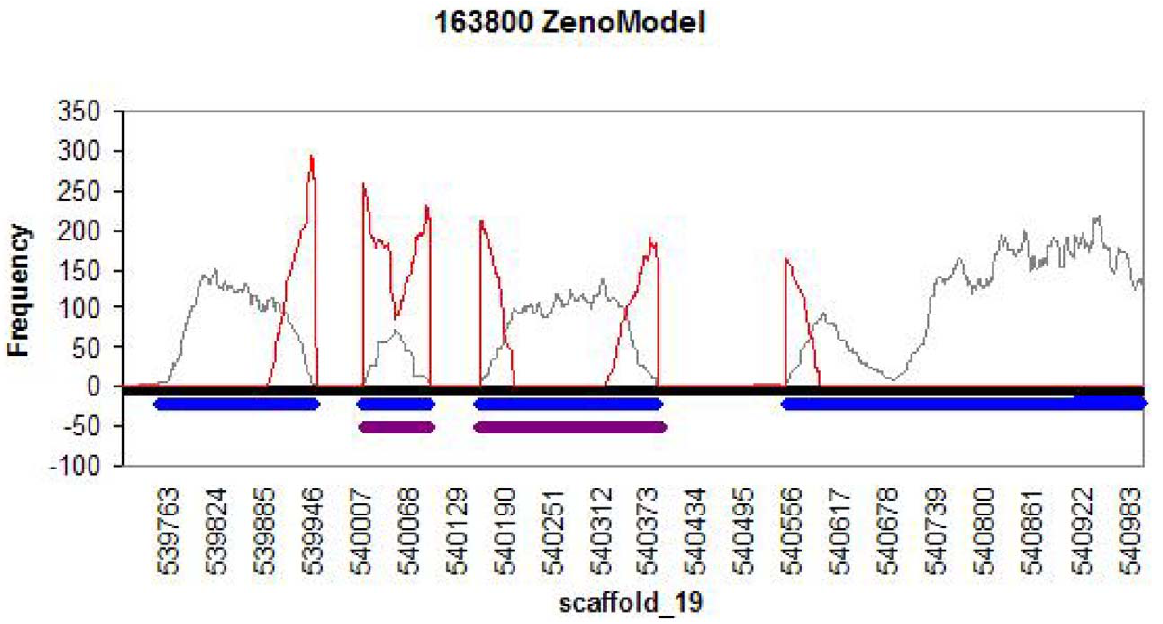
Figure 4. Comparison of the original and revised gene models encoding protein 163800 on genome sequence scaffold 19. Location on scaffold is on x-axis and numbers of read alignments at each bp is on the y axis. The gray line represents alignments to genomic sequence, The red lines are read alignments to JGI gene model and corrected gene model, but not to the genomic sequence. The sequence span of original gene model is displayed a green horizontal bar at the bottom of the transcript coverage trace. The revised gene model is displayed as a blue horizontal